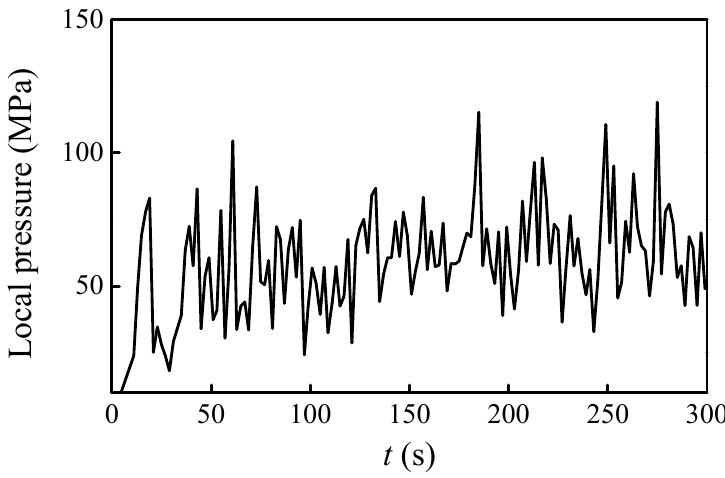
Figure 9. Local ice pressure versus time.